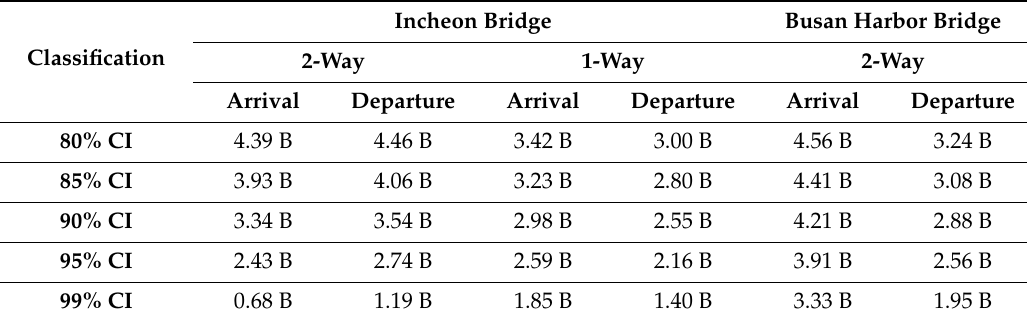
Table 13. Data for distance divided by ship’s maximum breadth for two bridges across waterways.